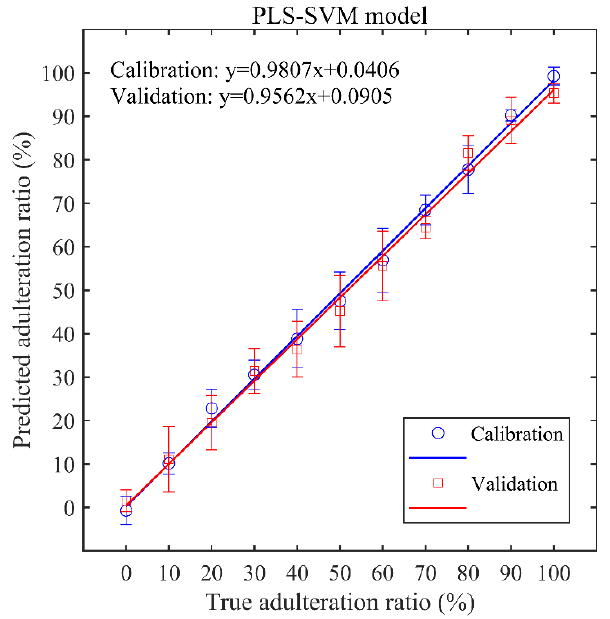
Figure 8. Calibration plots of the predicted adulteration ratio and true adulteration ratio based on the hybrid PLS-SVM model.